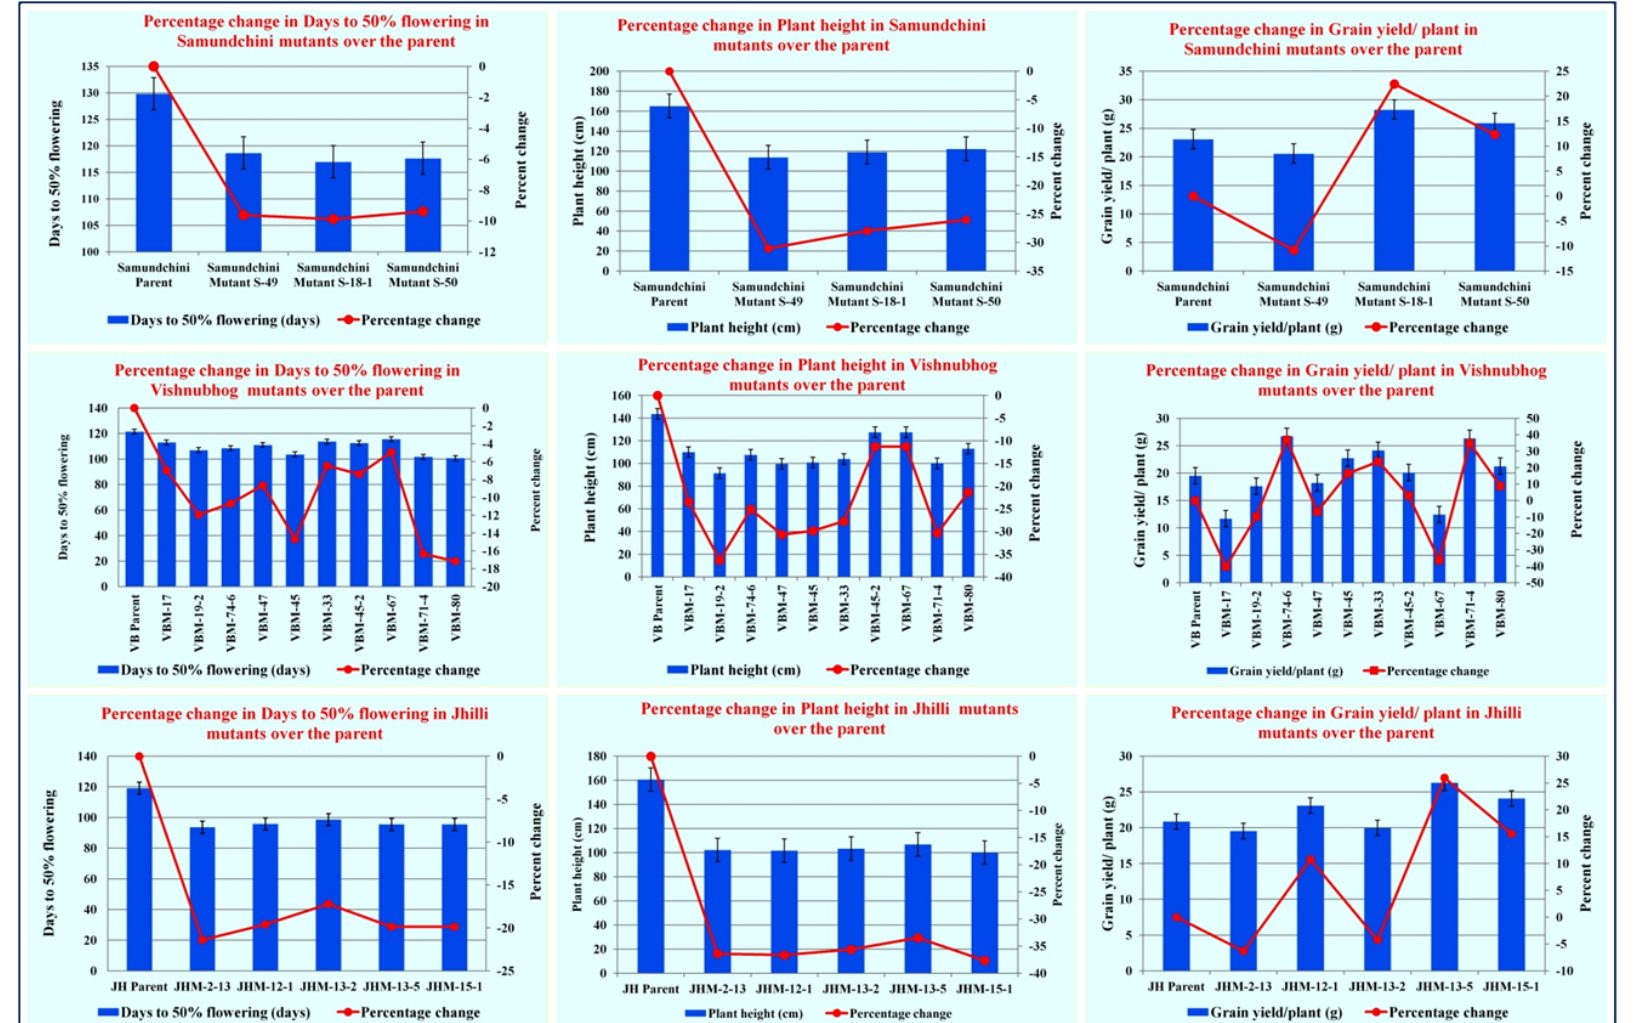
Figure 3. Percentage change in plant height, maturity duration and grain yield of mutants over the corresponding